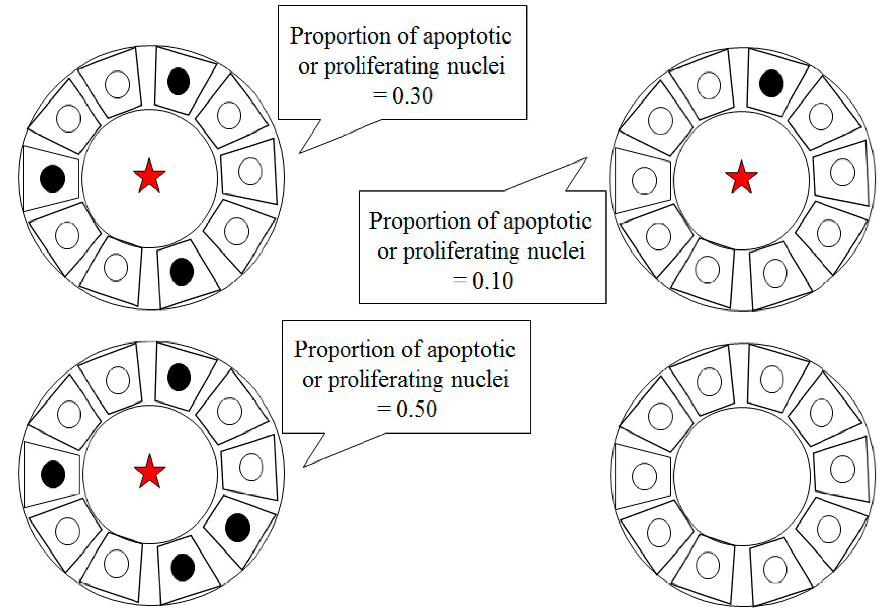
Figure 1. Renal tubule (PCT or DCT) cross sectional structures with positive staining to detect apoptosis or proliferation (marked with red asterisk). Calculation method for the percentage of apoptotic/proliferating cells in each tubule (black colored cell nuclei) according to K ę dzierska et al., 2015 [49].